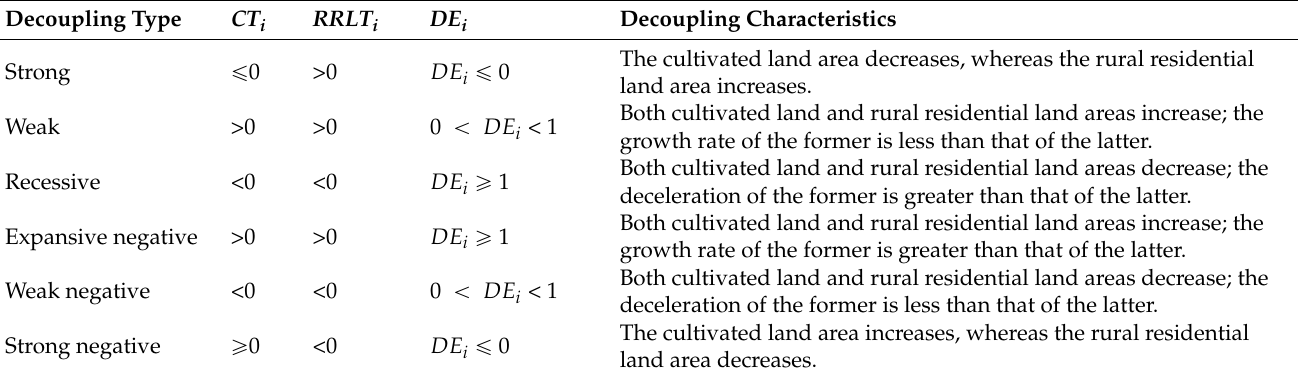
Table 1. Decoupling classification of cultivated land change and rural residential land change.